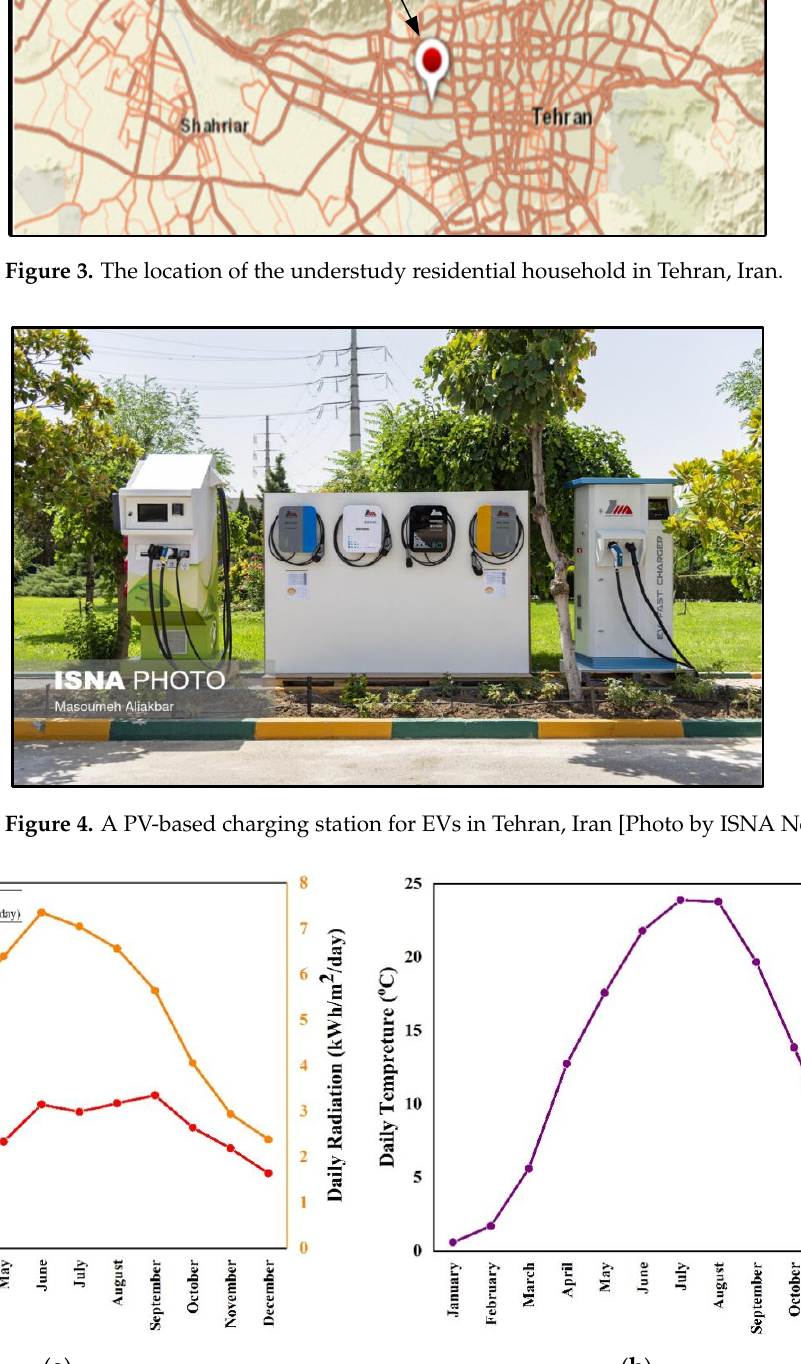
( c ) Figure 6. Yearly values of different types of load demand: ( a ) electric load; ( b ) thermal load; ( c ) EV electricity consumption. 5